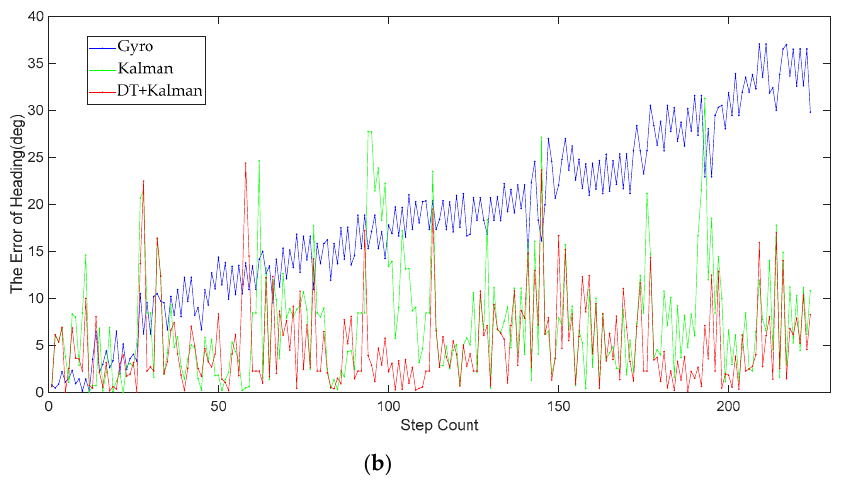
Figure 14. ( a ) The heading calculations of the three different algorithms for indoor pedestrian inertial navigation. ( b ) The error of the heading angle is based on the three algorithms.